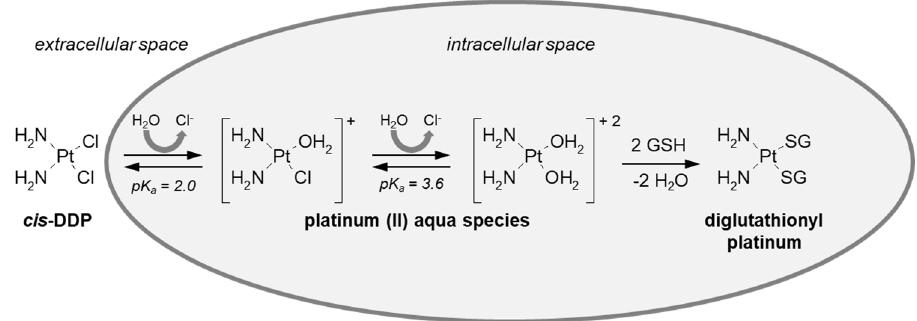
Figure 9. Reaction scheme of cisplatin ( cis -DDP) conjugation with GSH.